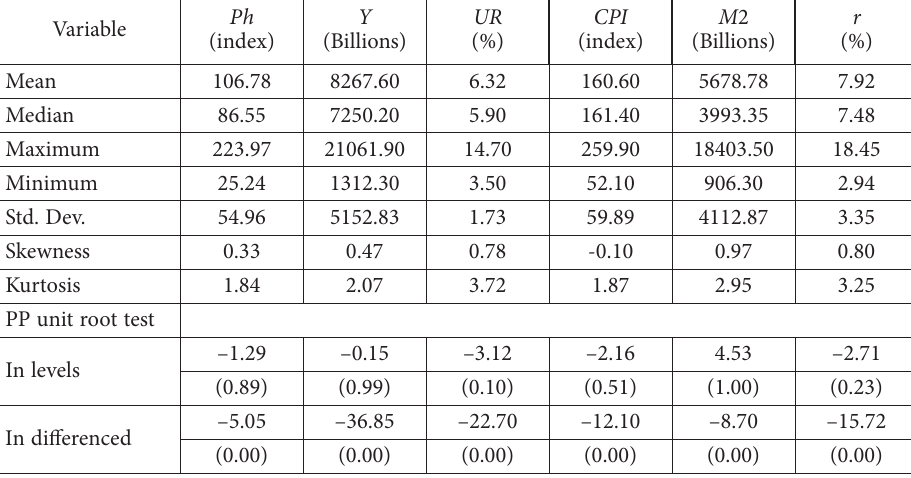
Table 1. Descriptive statistics and unit root